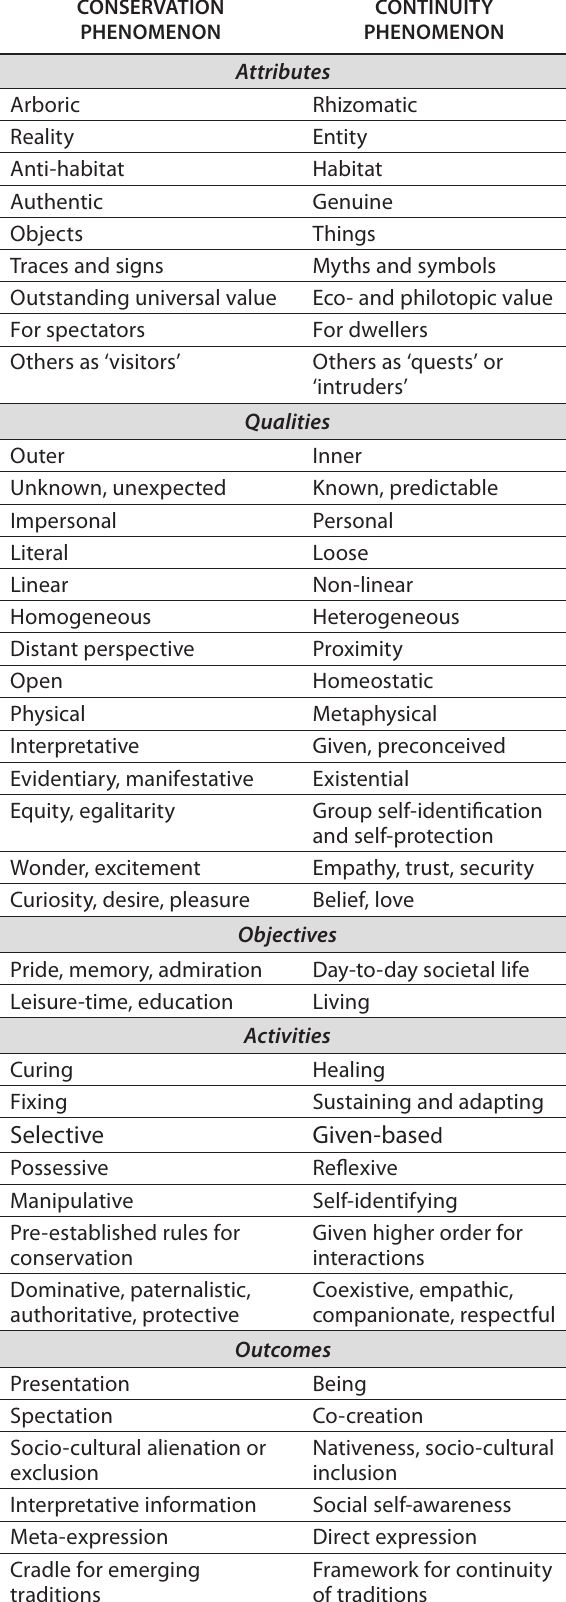
Table 1. Conservation and Continuity